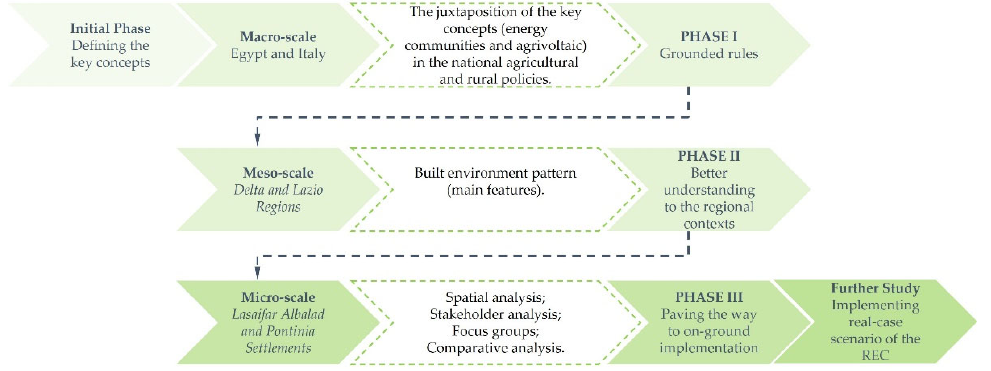
Figure 2. A visual summary of the study’s methodological concept.